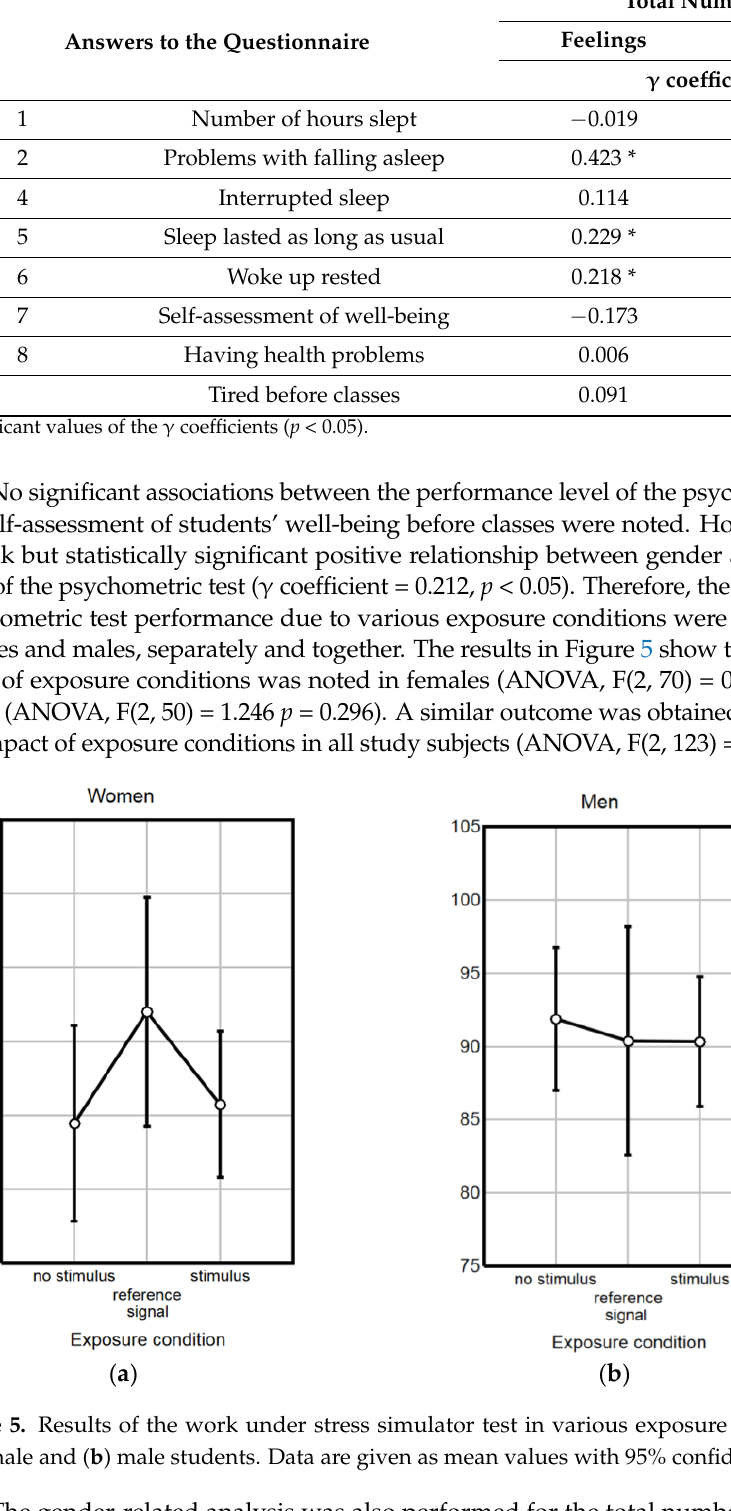
( b ) Figure 6. Total numbers of post-exposure feelings reported in various exposure conditions by ( a ) female and ( b ) male students. Data are given as median values with 5th, 25th, 75th and 95th percen- tiles.